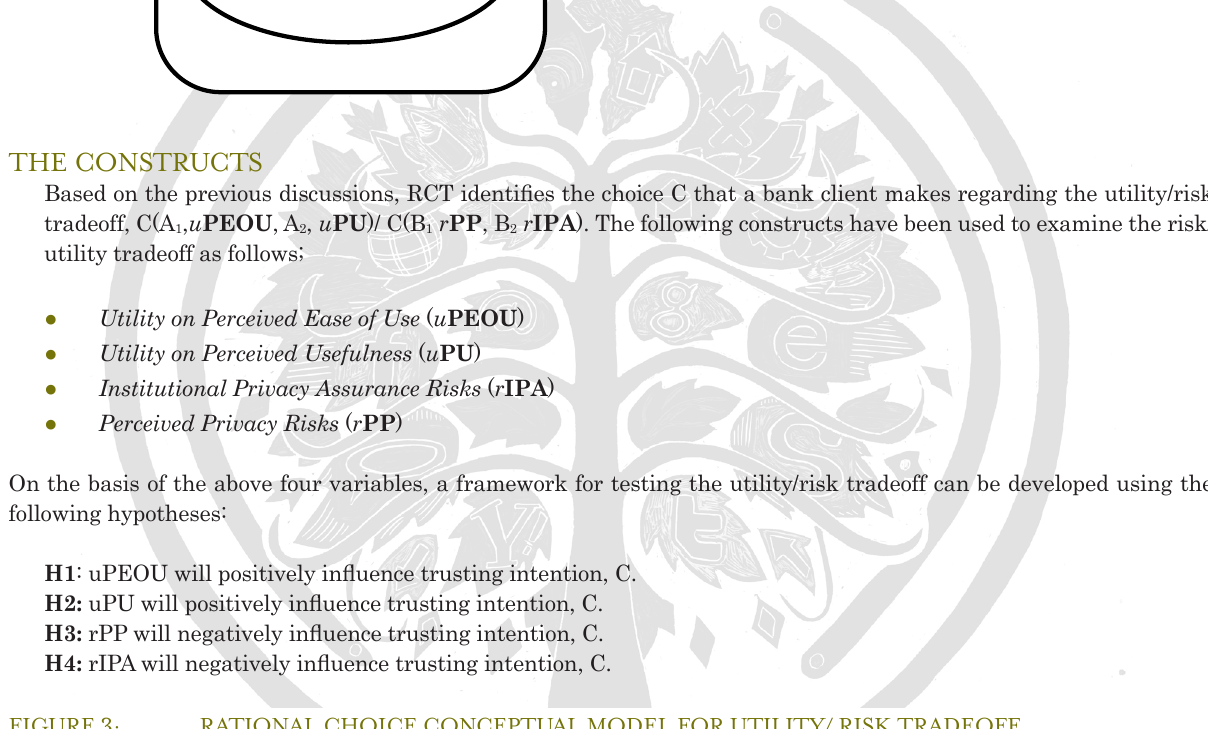
Institutional Privacy Assurance in Set B r IPA